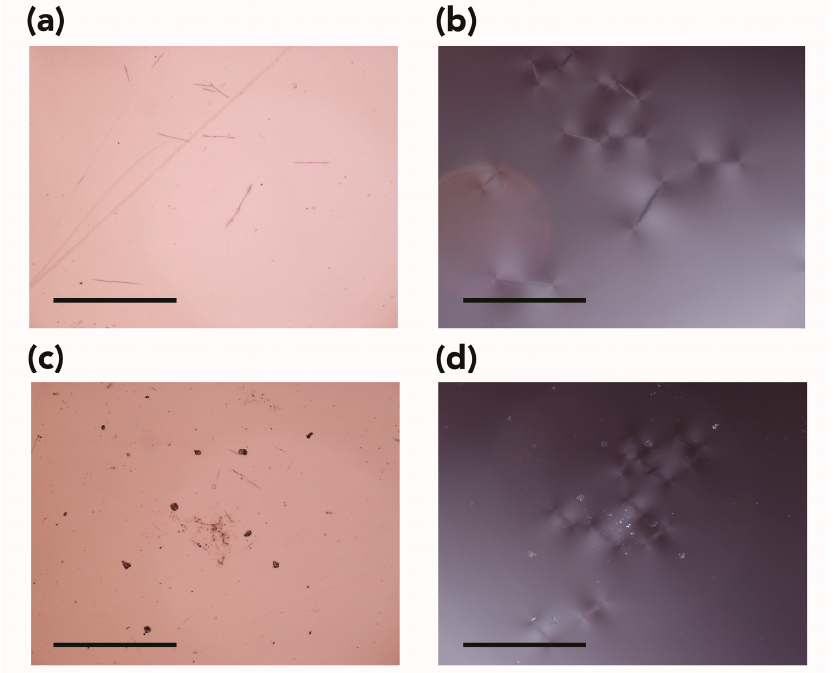
Figure 10. Representative microphotographs for: ( a ) control untreated sample, in reflected light in brightfield; ( b ) sample exposed to vapor CO 2 at 25 ◦ C and 6 MPa, in transmitted cross-polarized light; ( c ) sample exposed to liquid CO 2 at 25 ◦ C and 10 MPa, in reflected light in brightfield; ( d ) sample exposed to supercritical CO 2 at 35 ◦ C and 10 MPa, transmitted cross-polarized light. Magnification ×50.